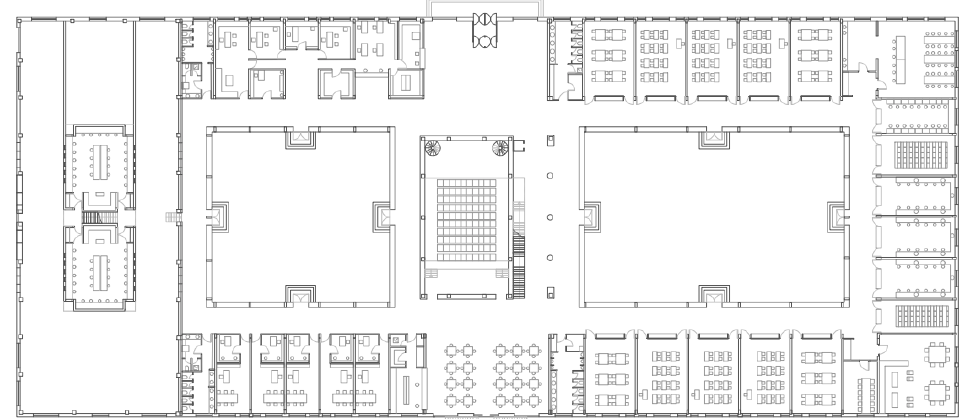
Figure 6. Plan of the Fishery Training School, Punta de Niño do Corvo, Arousa, designed by Pascuala Campos de Michelena (Authorship: